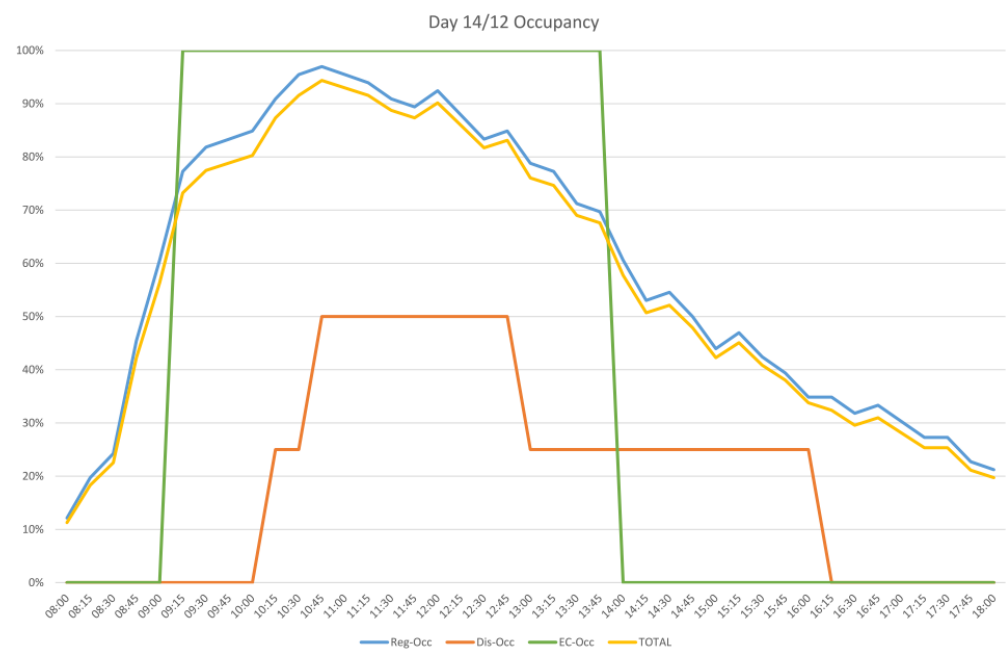
Figure 11. Percentage of parking occupancy on December